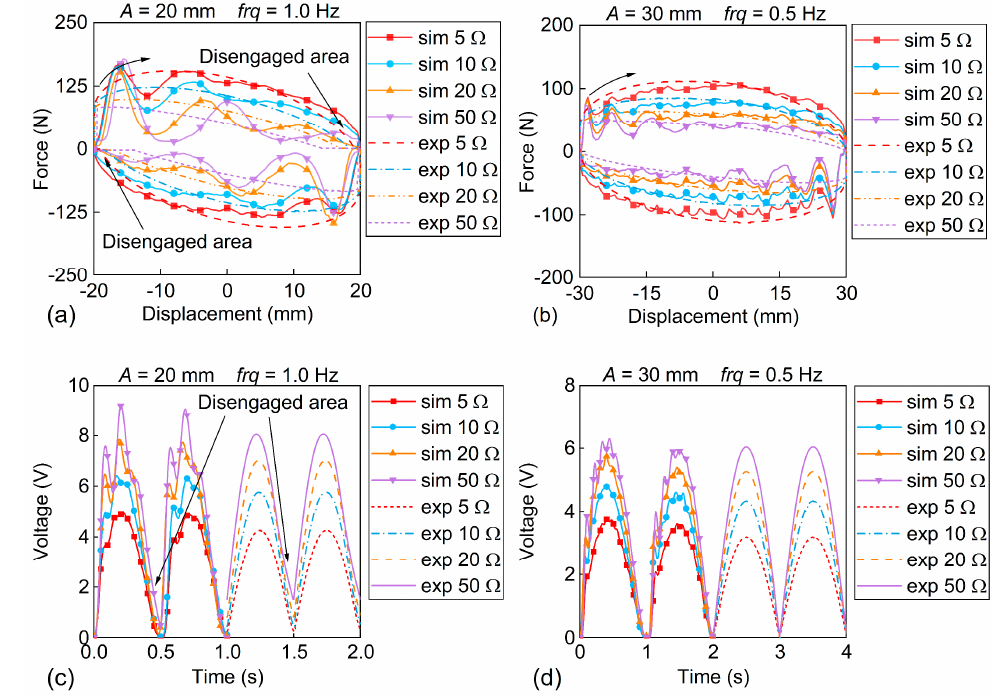
Figure 8. Simulation and experiment. ( a ) Total force ( A = 20 mm, f = 1.0 Hz). ( b ) Total force ( A = 30 mm, f = 0.5 Hz). ( c ) Voltage ( A = 20 mm, f = 1.0 Hz). ( d ) Voltage ( A = 30 mm, f = 0.5